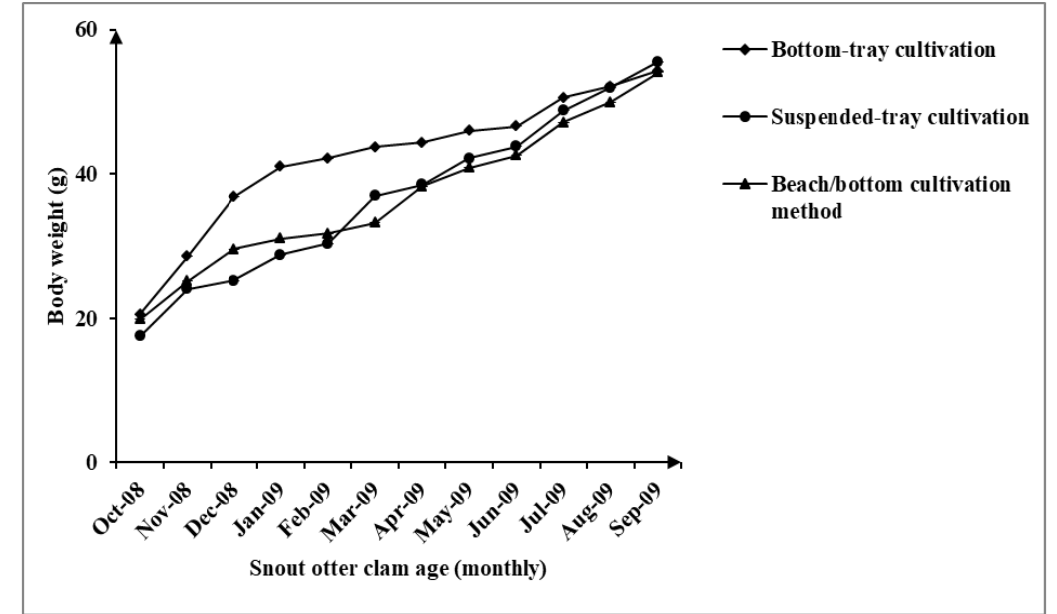
Figure 4. Study was conducted from October 2008 to September 2009, this results showed monthly average of body weight (BW) of snout otter clams in bottom-tray cultivation, suspended-tray cultivation, and beach/bottom cultivation methods. The values represented the average of three replicates ± SD.